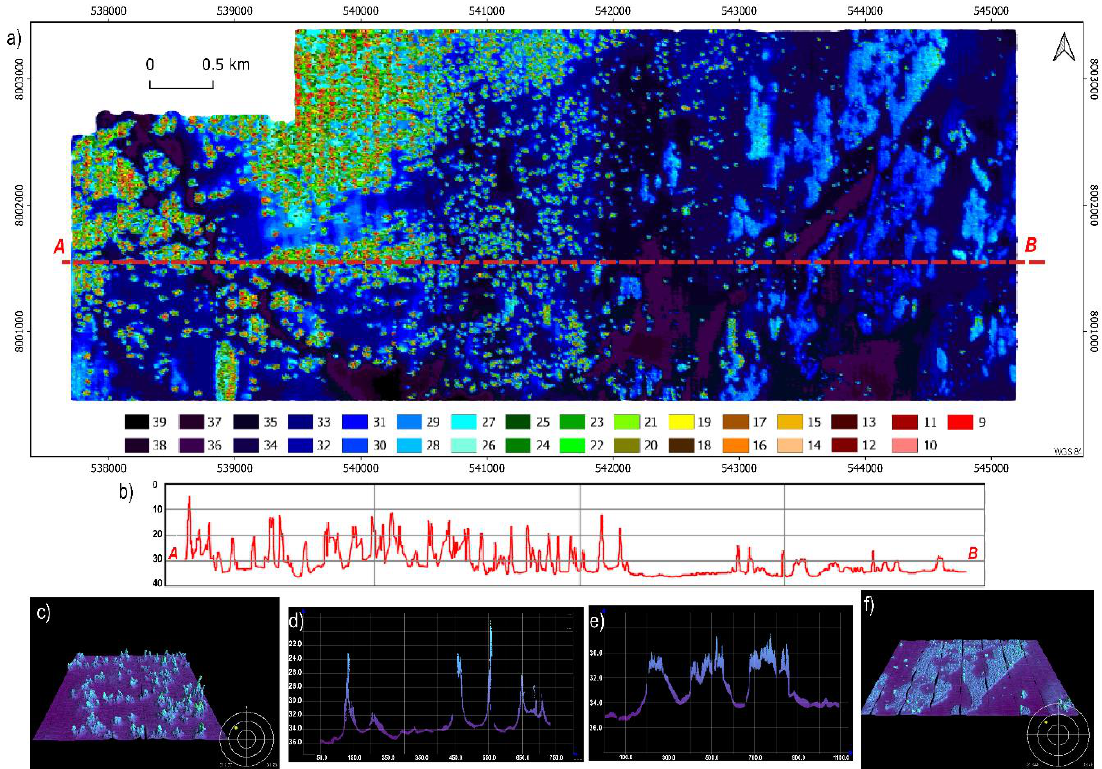
Figure 3. ( a ) DBM of the study area; ( b ) bathymetric profile A-B; ( c ) 3D view of the isolated pinnacles; ( d ) 2D view of the isolated pinnacles; ( e ) 2D view of the LRRB; ( f ) 3D view of the LRRB. Table 3. Classes adopted for each classification